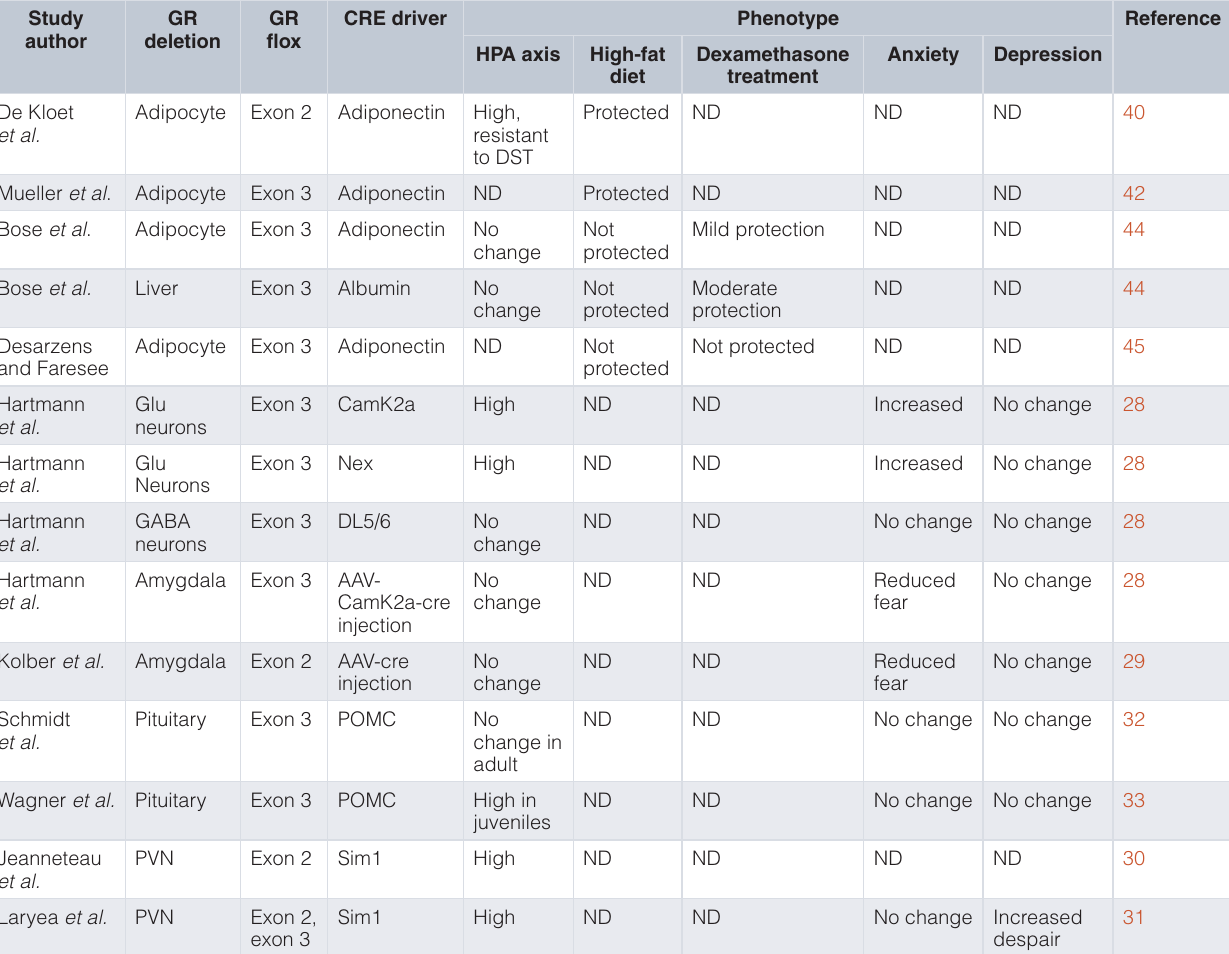
Table 1. Summary of the glucocorticoid receptor tissue-specific null mice discussed in this